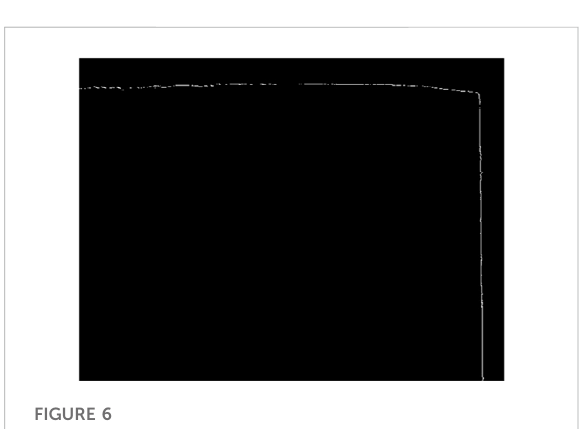
FIGURE 6 Image difference between i second and j second